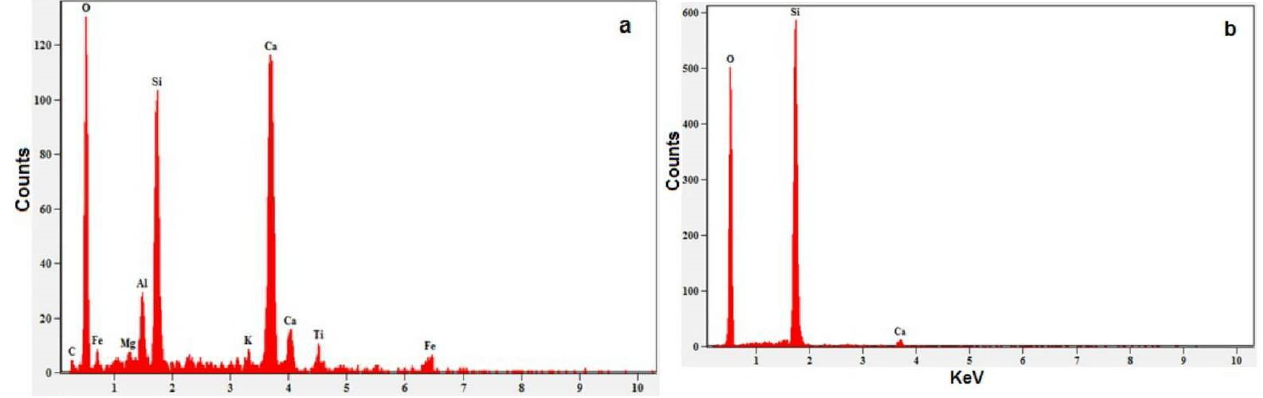
Figure 14. EDAX of concrete powder sample ( a ) NW with 1% optimized SP ( b ) MW with 0% SP.